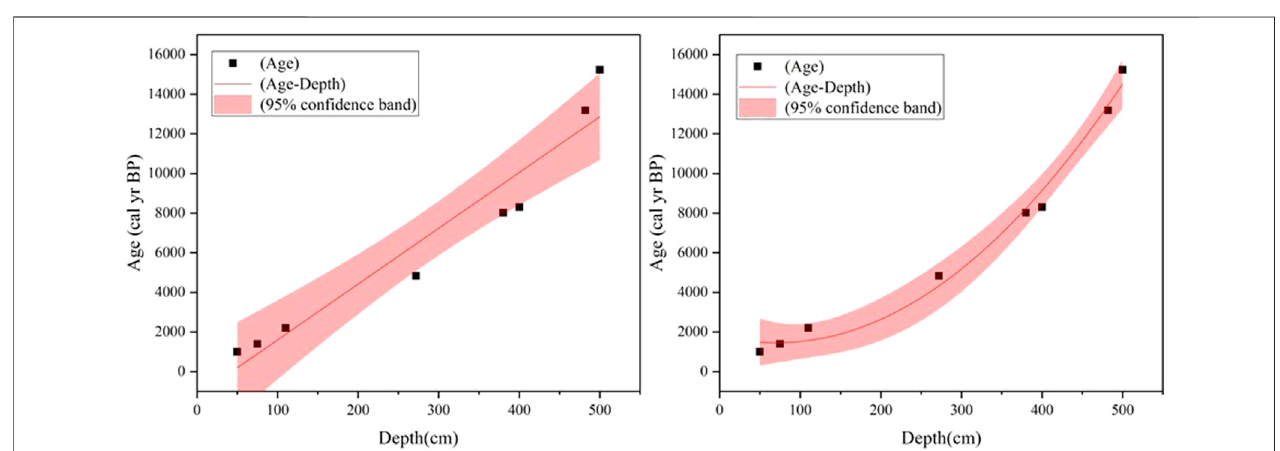
FIGURE 3 | Relationship between ages and depths in the HL18-3 core. The former is the linear relationship and the latter is the quadratic regression relationship.